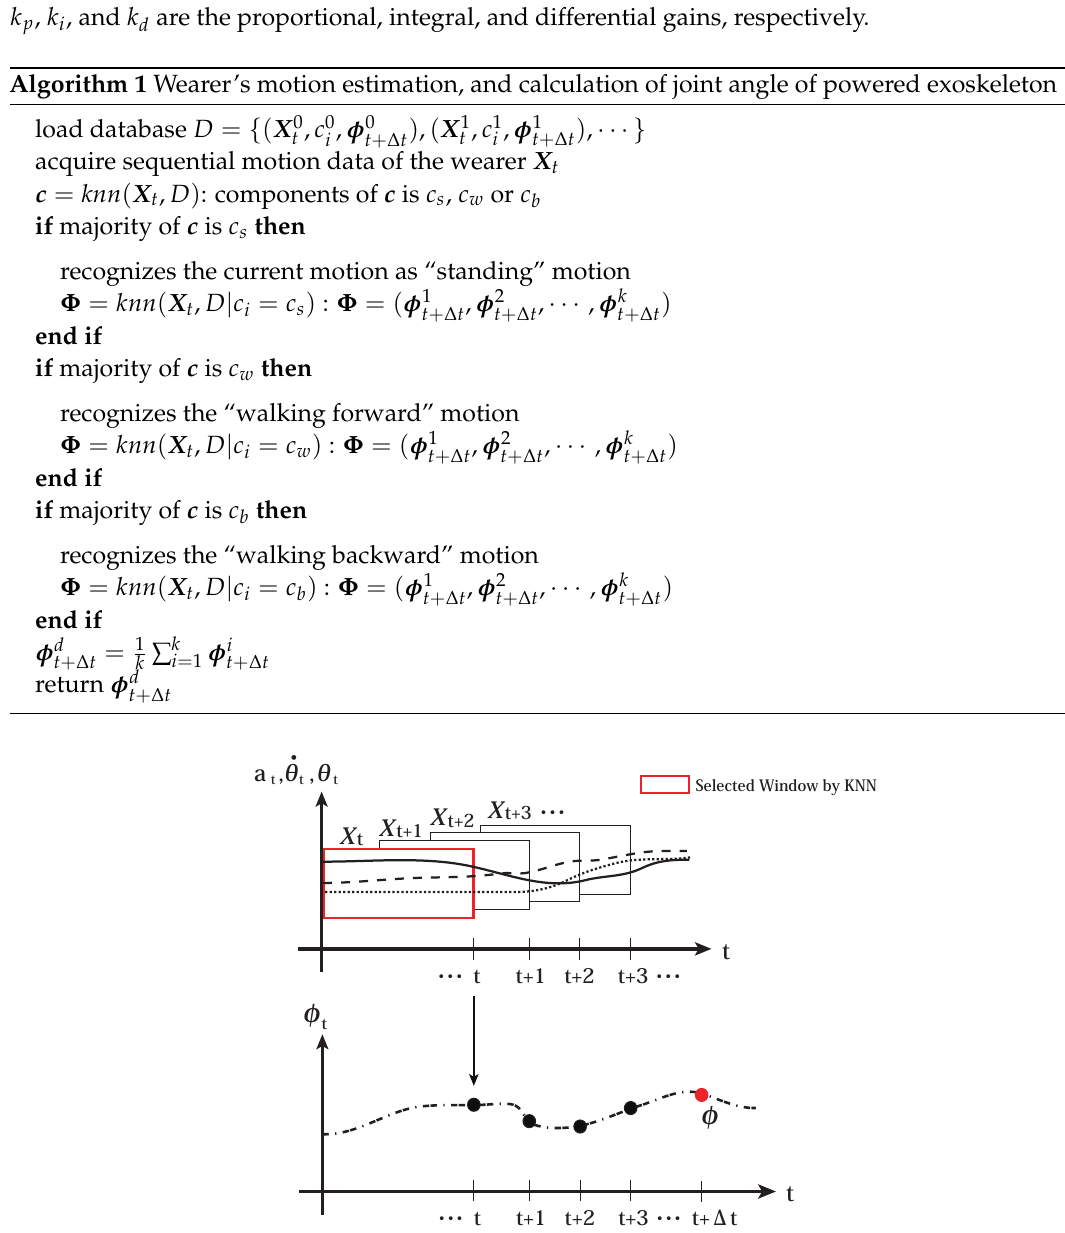
Figure 5. Estimation of joint angle at time t + ∆ t , φ t + ∆ t , based on